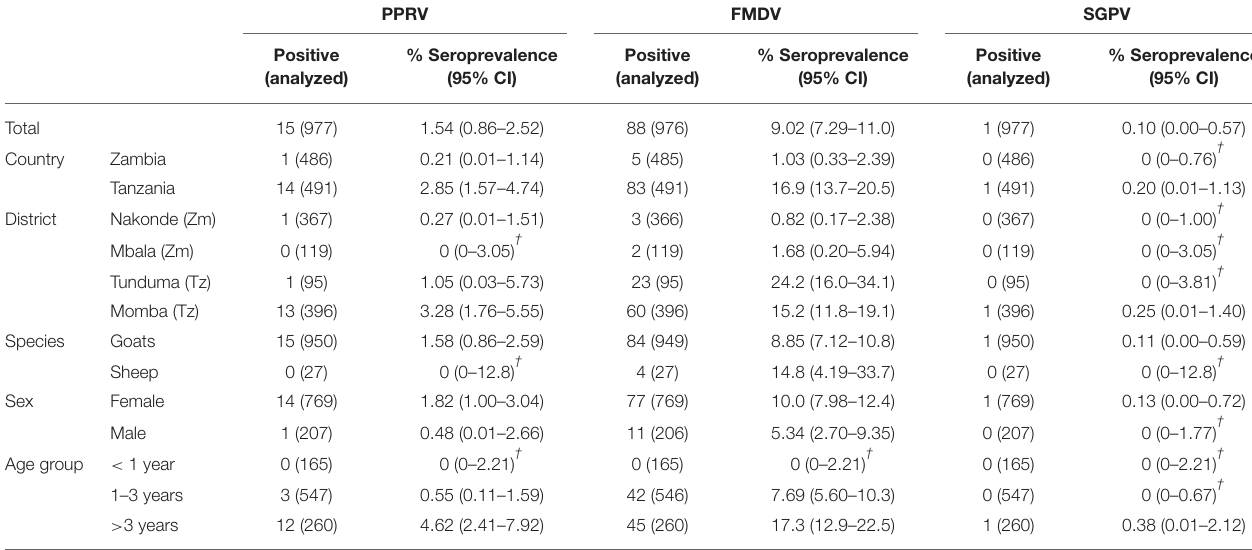
TABLE 3 | Apparent animal-level seroprevalence for PPRV, FMDV and SGPV.